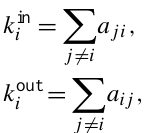
m 14 /P 4 andthe contribution · m 13 /P 3 m 14 /P 4 . The legend is the · ·